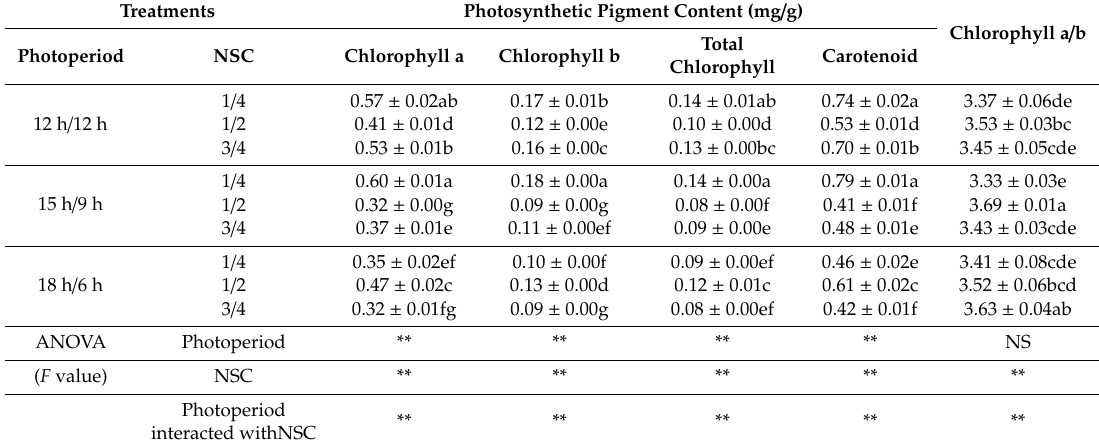
Table 3. The e ff ect of photosynthetic pigment under the interaction of photoperiod and NSC. Treatments Photosynthetic Pigment Content (mg / g)